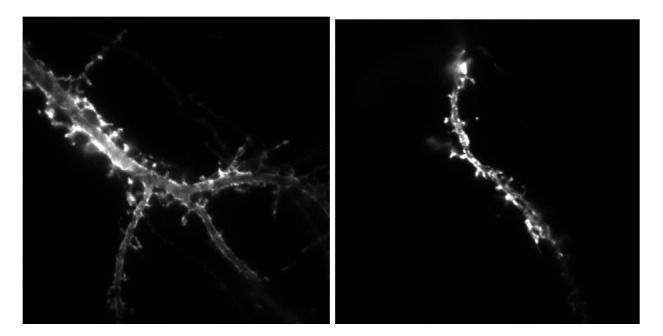
Example of neurons labelled with anti-HA alexa647nm in culture transfected by either Nlg1HA-IRES-GFP or NLG1HA-ΔCter IRES GFP plasmids, used for lentivirus production.